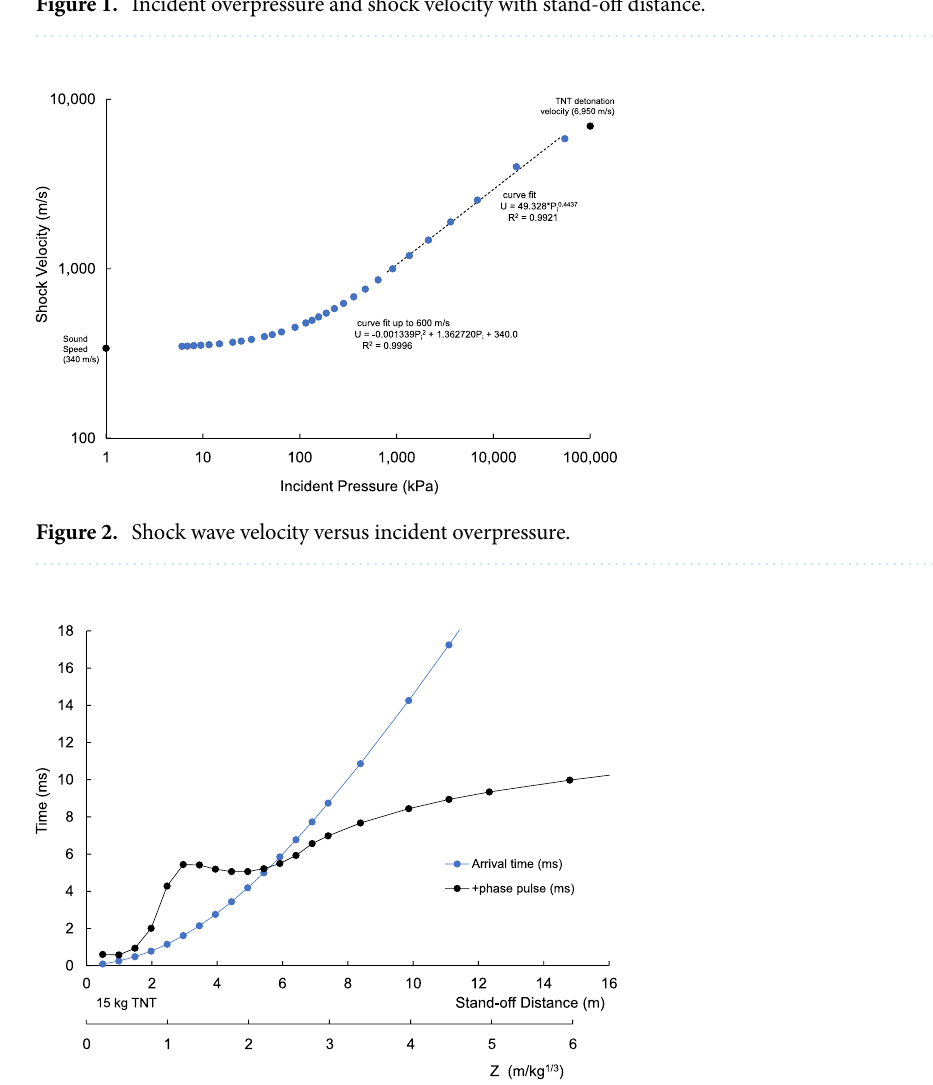
Figure 1. Incident overpressure and shock velocity with stand-off distance.